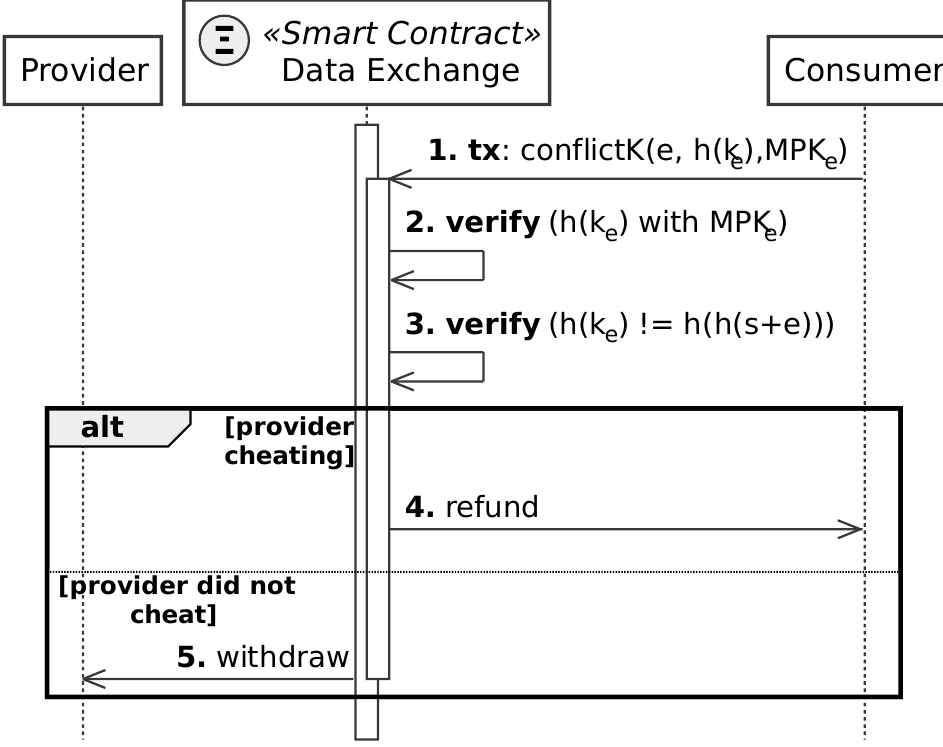
Figure 7. Protocol resolution-k: sequence